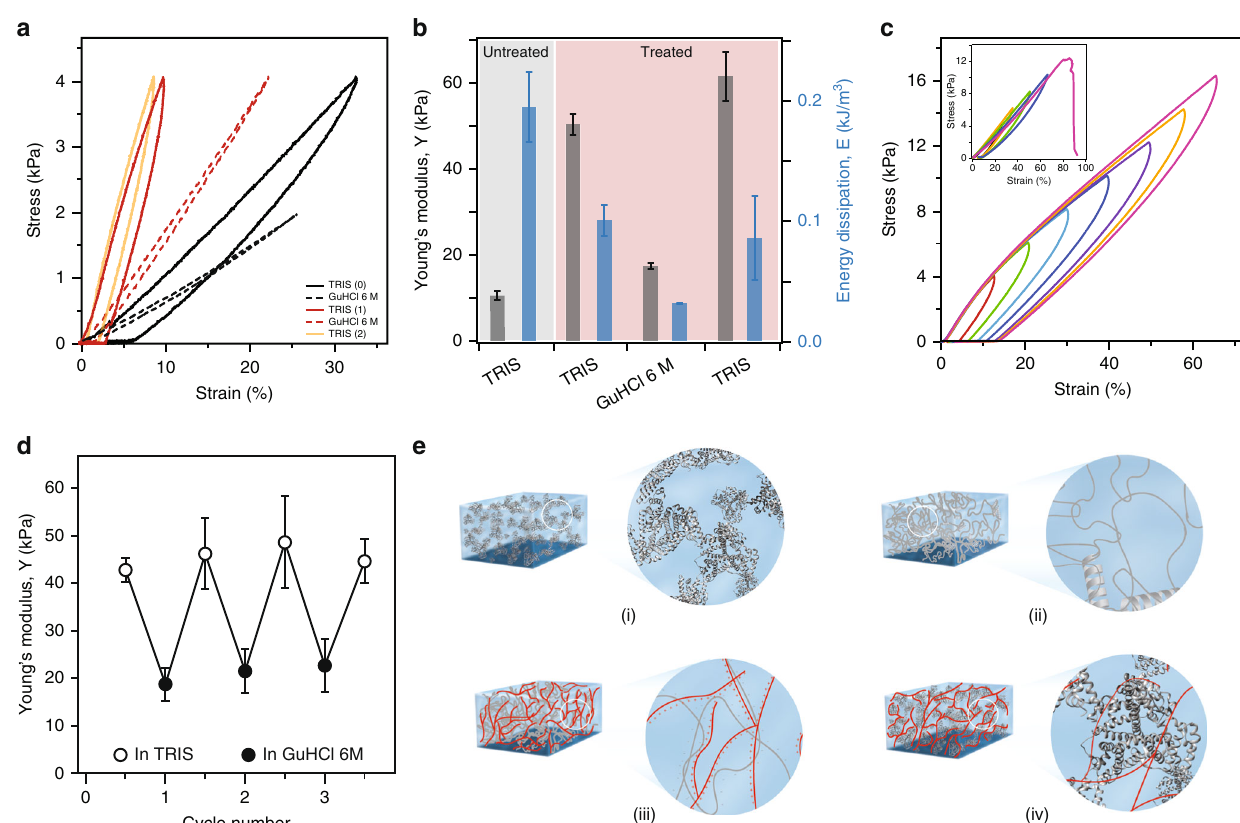
Fig. 3 PEI stiffens BSA hydrogels without preventing chemical denaturation of protein domains. a Stress – strain curves of same BSA-based hydrogel sample in TRIS (black continuous without PEI, red continuous with PEI) and 6 M GuHCl (black dotted without PEI, red dotted with PEI). The gel recovers the initial elastic properties upon immersion from GuHCl back to TRIS (orange trace). This reversible behavior enables shape memory and reversible shape change using chemical (un)folding. b Average Young ’ s moduli and energy dissipation of same BSA-based hydrogel sample in TRIS and 6 M GuHCl before and after treatment with 2 mM PEI solution. c Stress – strain of PEI-treated BSA-based hydrogel sample showing that it can withstand successive loading – unloading cycles with increasing fi nal stresses while showing a pronounced hysteresis and recovery. Inset: Stress – strain of BSA-based hydrogel sample failed after successive loading – unloading cycles of increasing force. d Dynamic change of the Young ’ s modulus of BSA hydrogels treated with 2 mM PEI in response to switching between native (in TRIS) and denaturing (in GuHCl 6 M) buffer conditions. e Proposed mechanisms for the strengthening of treated PEI – BSA- based hydrogel: (i) Covalent crosslinking between BSA domains. (ii) Protein (un)folding nanomechanics. (iii) Non-covalent electrostatic crosslinking between unfolded BSA domains and PEI molecules, and (iv) PEI molecules stabilize a BSA domains through electrostatic interactions. All error bars are SD from n = 3 independent hydrogel